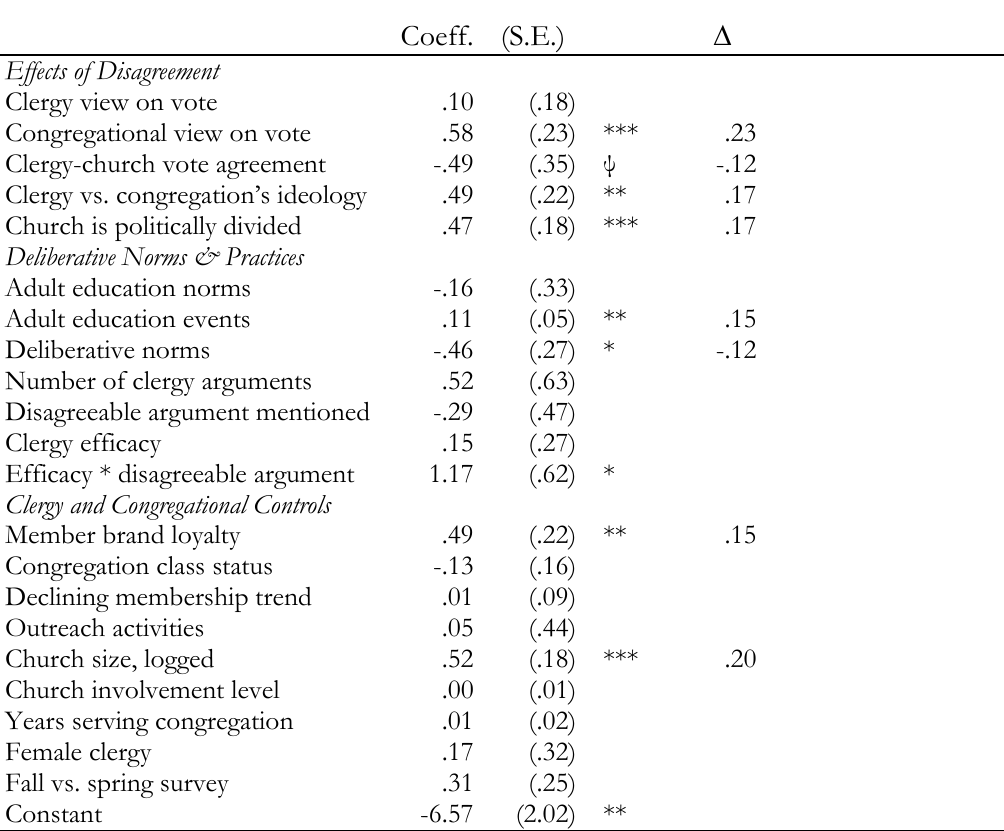
Table 1 : Whether the Congregation Held an Open Meeting on the ELCA Vote (Logistic Regression